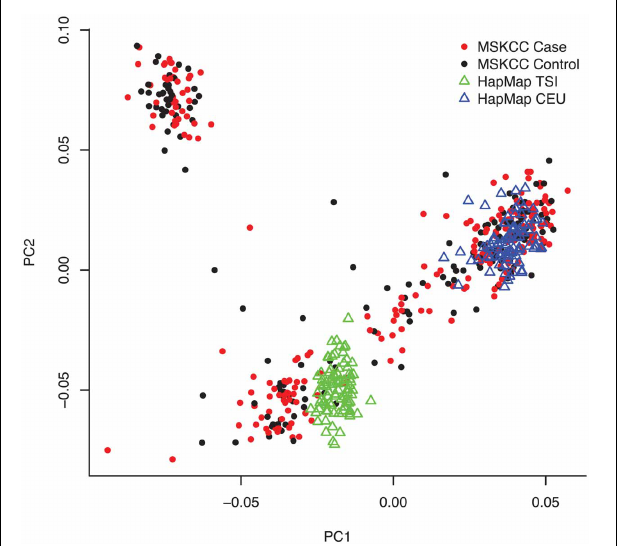
FIGURE 1 | Population structure of the study samples revealed by principal component analysis. Following SNP array genotyping, we applied the EIGENSTRAT package to 43,909 pairwise independent ( r 2 < 0 . 1) SNPs with minor allele frequency (MAF) > 0.05 and call rates > 95% among the 223 pancreatic cancer cases, 169 controls, and 253 individuals from reference HapMap CEU and TSI populations. A plot of the top two principal components of genetic variation (PC1 and PC2) is shown with cases as red dots, controls as black dots, CEU reference samples as blue triangles, and TSI reference samples as green triangles. As expected for our New York-based population study, the majority of cases and controls clustered with either the CEU reference samples (i.e., central European ancestry) or TSI (southern Italian ancestry). A subset of cases and controls (representing those with Ashkenazi Jewish ancestry) clustered